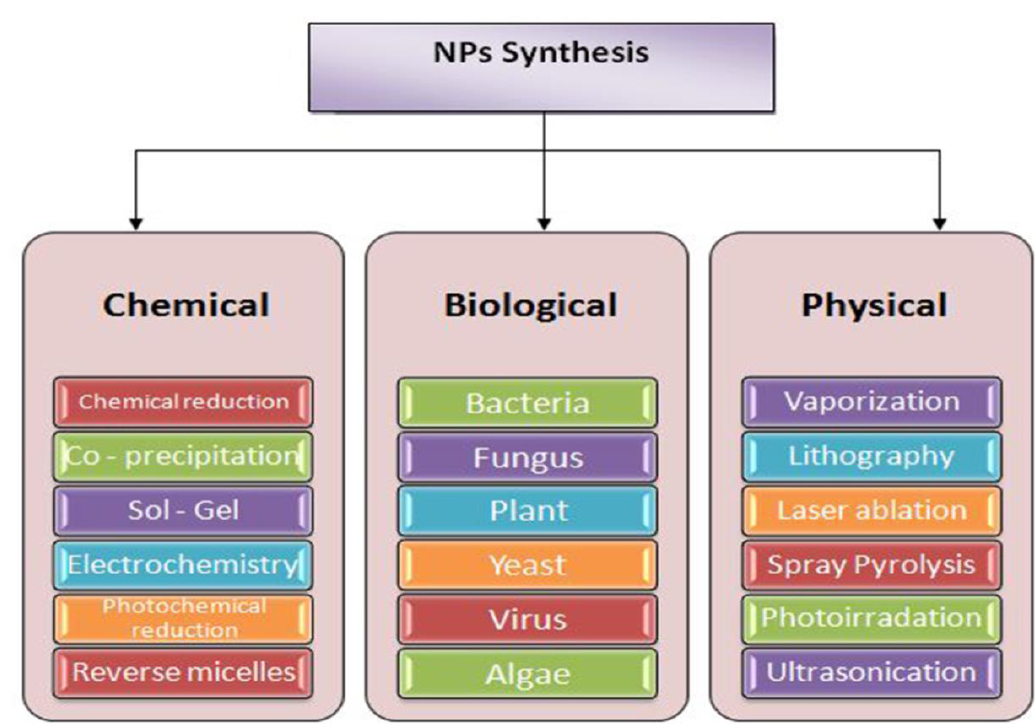
Figure 2. Method of nanoparticles synthesis.